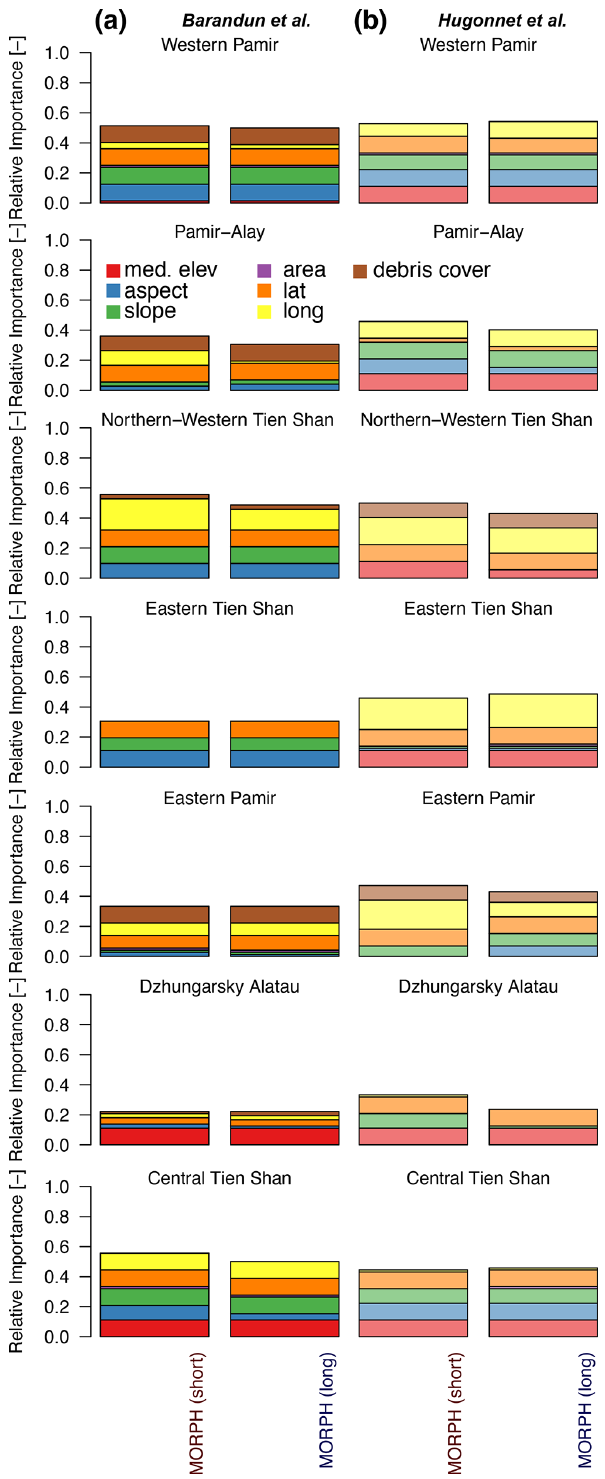
Figure A4. Frequency of significant morphological variables for the HIMAP regions and for the two mass balance estimates by (a) Barandun et al. (2021a) and (b) Hugonnet et al.